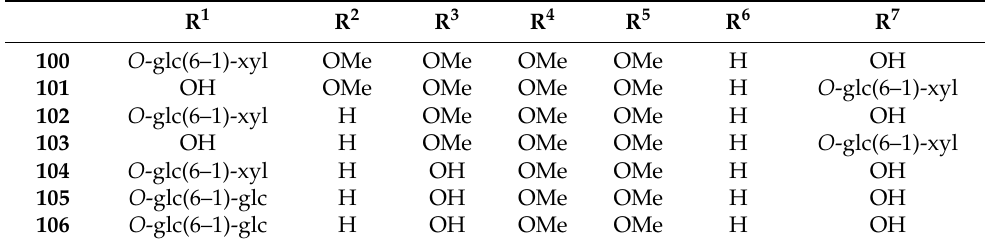
Table 4. The structure of compounds 100 – 106